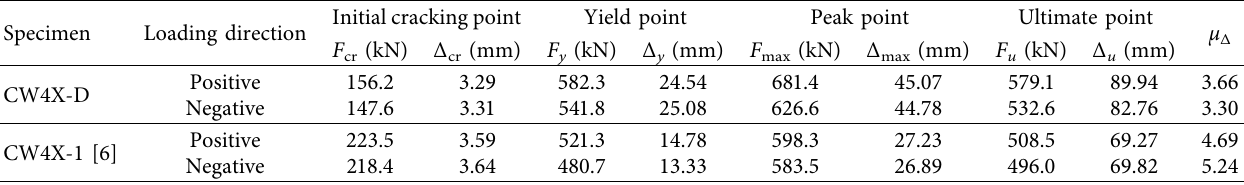
Figure 9: Skeleton curves. Table 2: Load-bearing capacities and deformation capacities at key points and ductility coefficient.